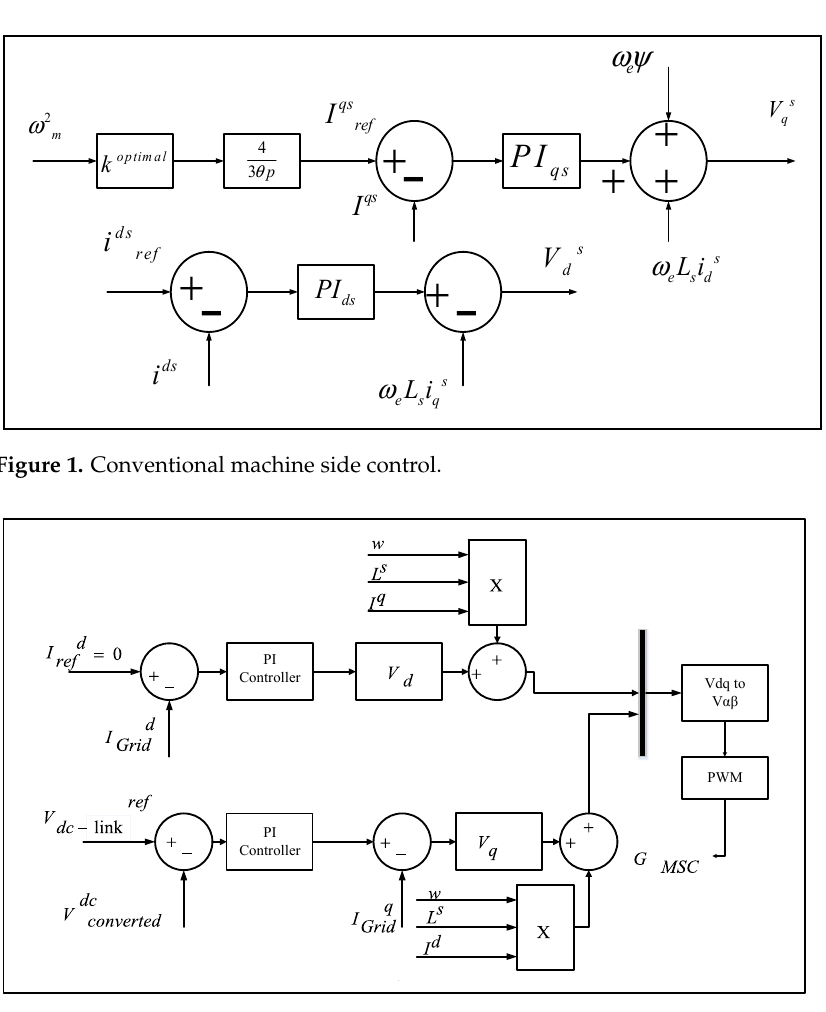
Figure 2. Proposed machine side control.